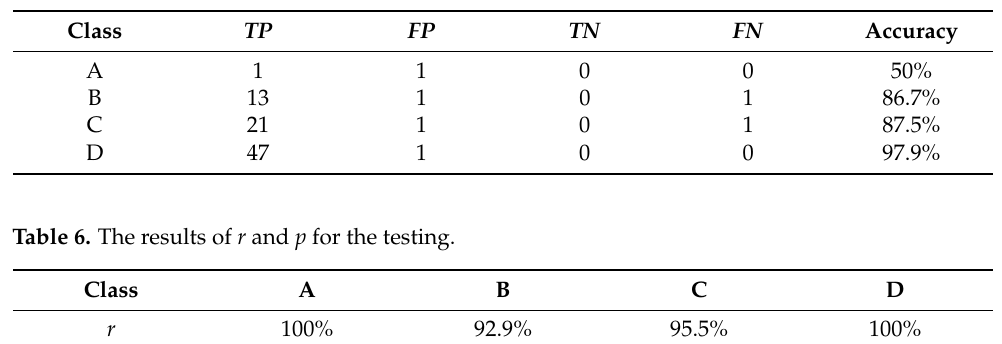
Table 5. The classified results for TP , FP , TN , and FN .